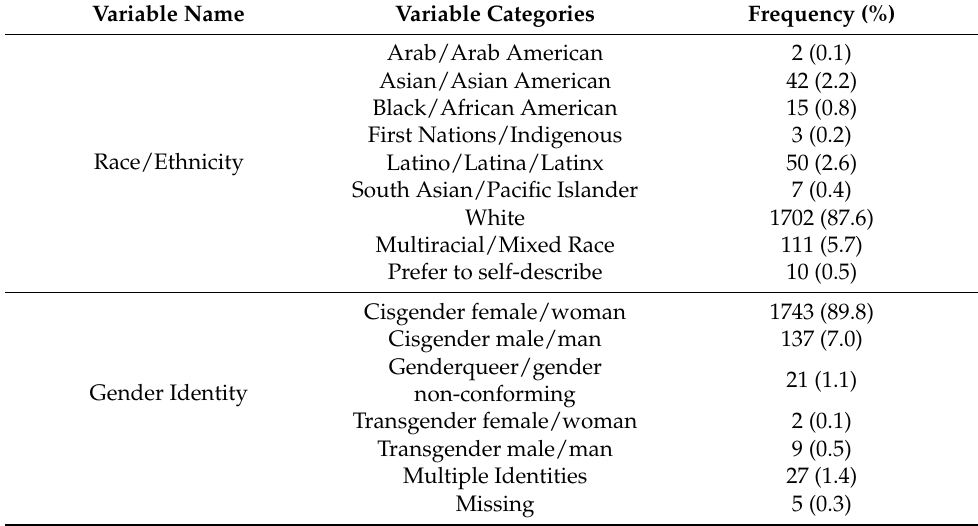
Table 1. Demographic Characteristics of Sample ( n =